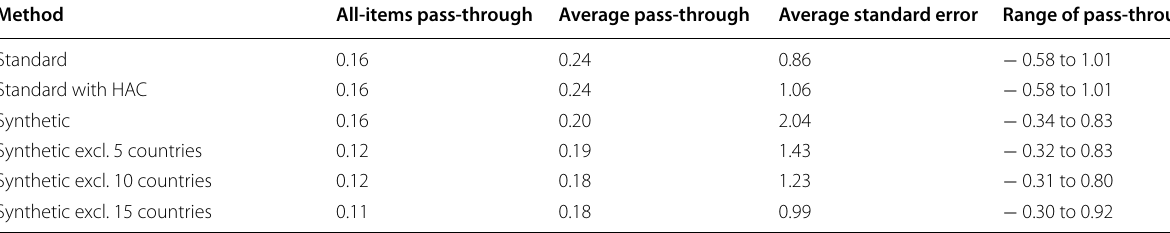
Table 4 Comparison of different DID methods